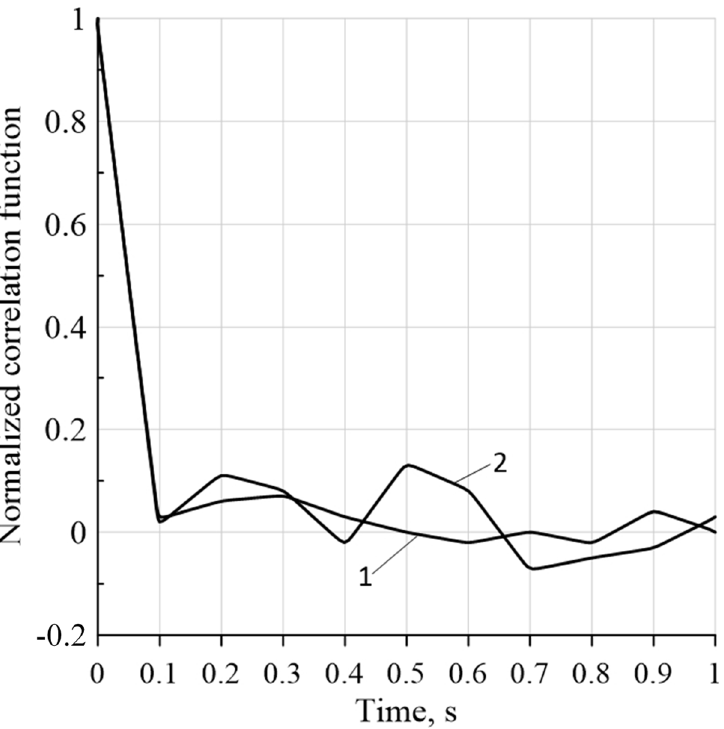
Figure 7. Normalized oscillation correlation functions of traction. Plowing resistance of the PLN-5-35 plow with skimmers (1) and without them (2).